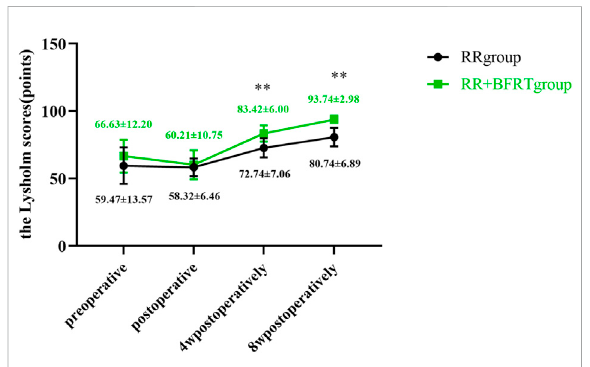
FIGURE 13 Comparison of Lysholm scores between RR group and RR + BFRT group at different time points (points). “ ** ” indicates a signi fi cant change ( p < 0.01). Values are presented as mean ± SD. RR Group: routine rehabilitation group; RR + BFRT Group: routine rehabilitation + blood fl ow restriction training group.